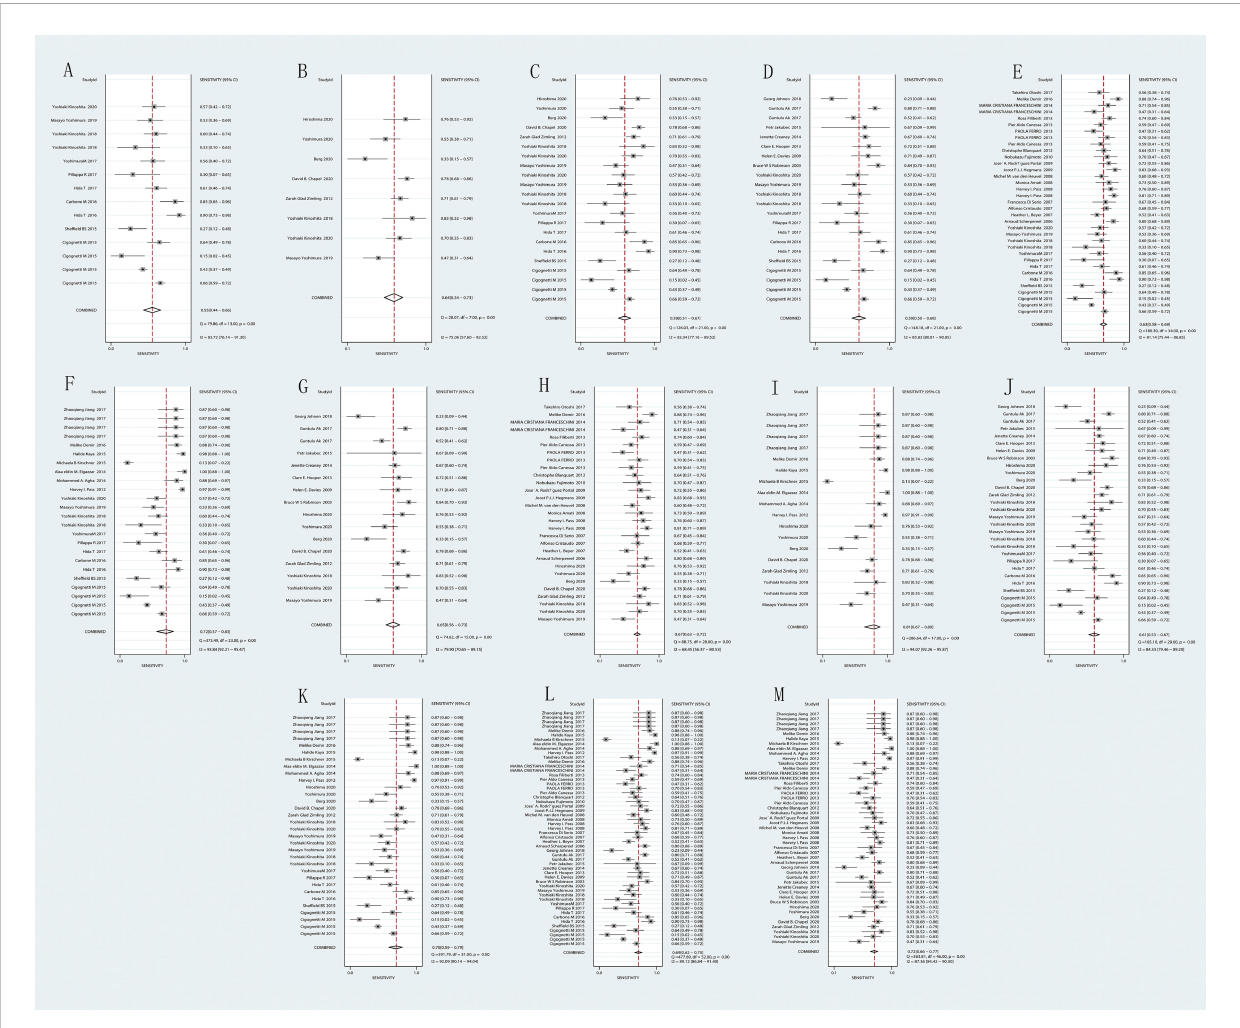
FIGURE 2 Forest plot for the pooled sensitivity of biomarkers. (A) BAP1; (B) MTAP; (C) BAP1+MTAP. (D) BAP1+MSLN; (E) BAP1+SMRP; (F) BAP1+ Fibulin-3; (G) MTAP+ MSLN; (H) MTAP+ SMRP; (I) MTAP+ Fibulin-3; (J) BAP1+MTAP+MSLN; (K) BAP1+MTAP+ Fibulin-3; (L) BAP1+MSLN+SMRP+Fibulin-3; (M)